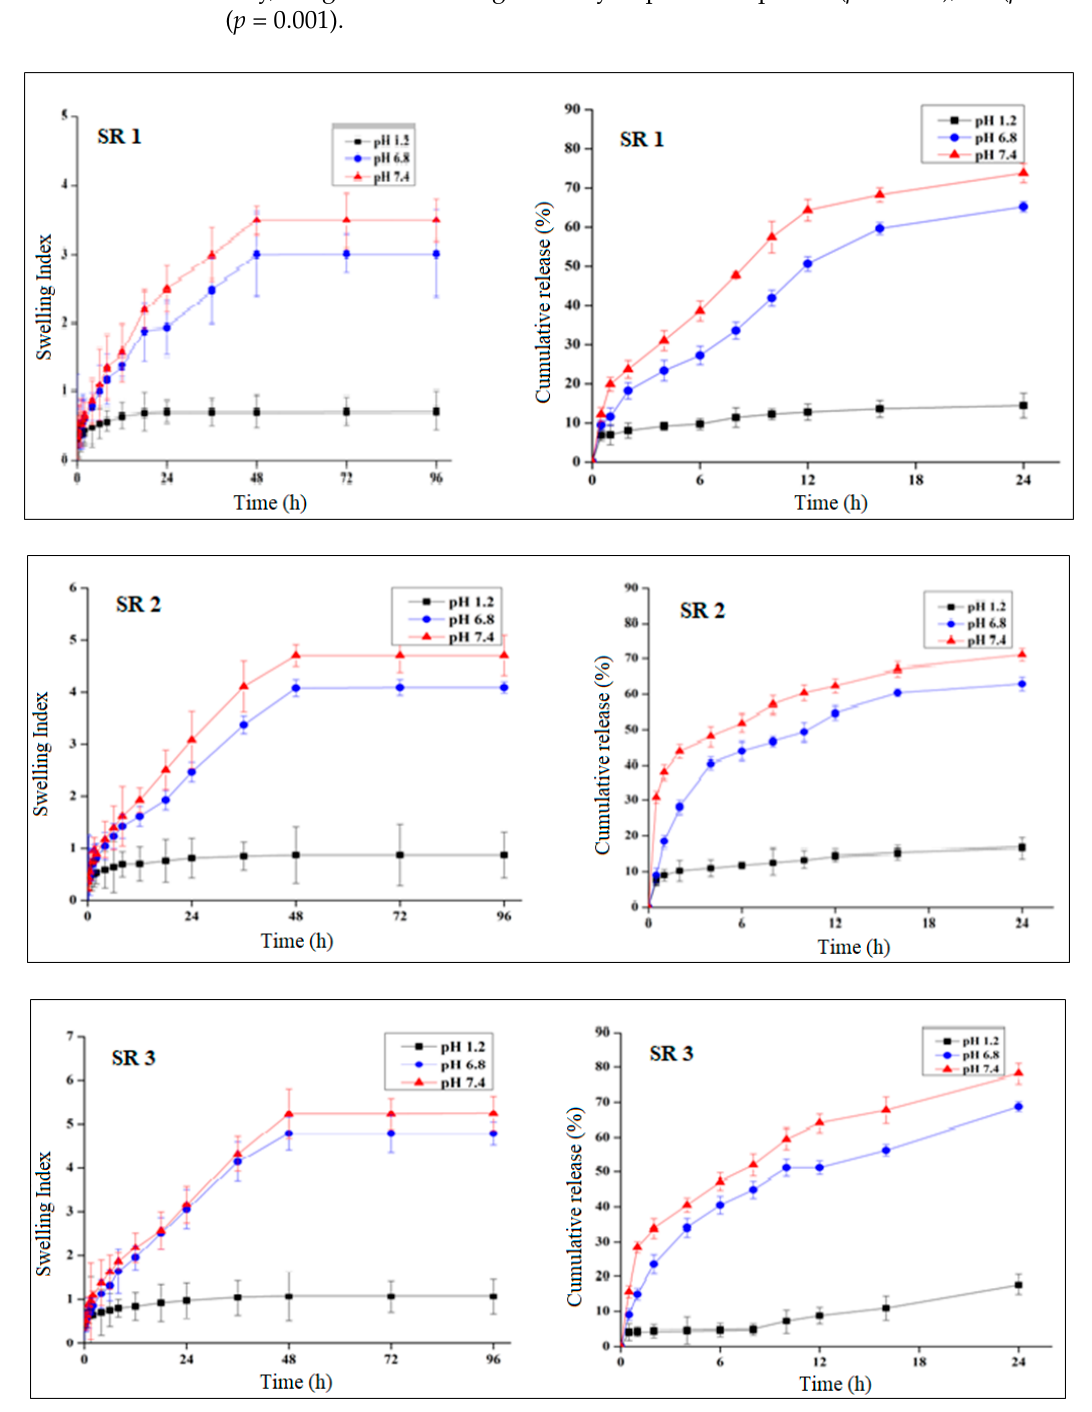
Figure 5. Swelling ratio and percentage drug release of formulation AC1-AC3. The swelling index of the formulations (MB1-MB3) was extensively decreased at pH 1.2 ( p = 0.003), 6.8 ( p < 0.000), and 7.4 ( p < 0.001) (Figure 6). Following the swelling, there was also major decline in drug release at pH 1.2 ( p < 0.000), 6.8 ( p < 0.001), and 7.4 ( p < 0.003).